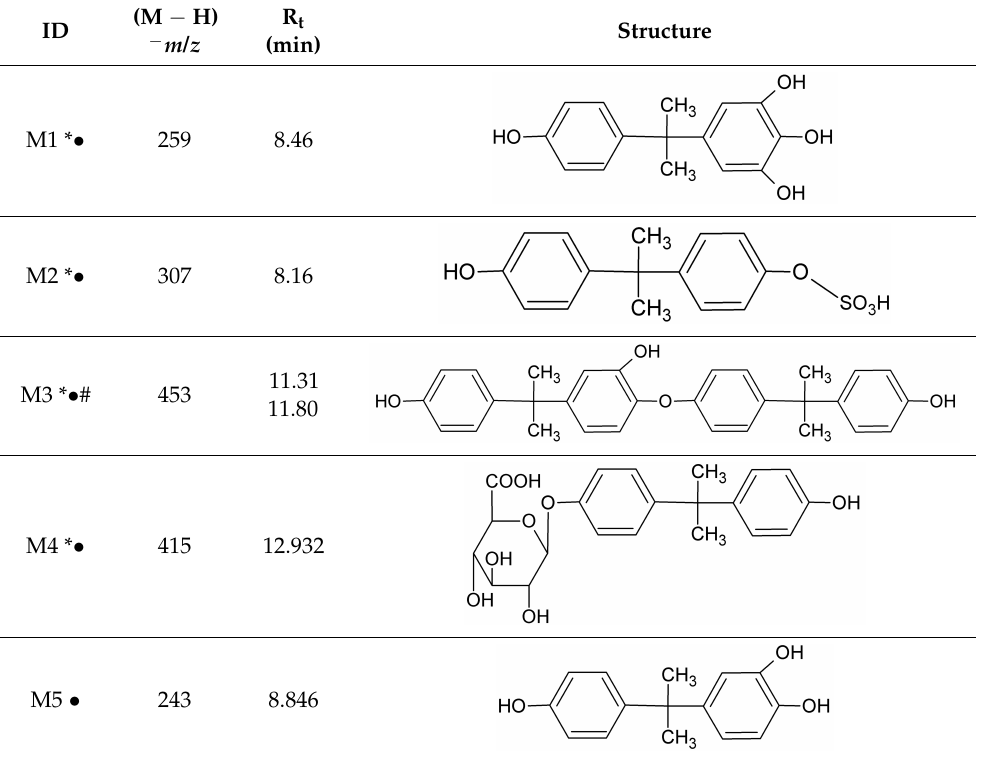
Table 1. Metabolites identified in M. roridum IM 6482 cultures cultivated in modified Czapek-Dox medium with BPA or BPA/copper sulfate mixture and after M. roridum laccase incubation in water solution containing 50 mg · L − 1